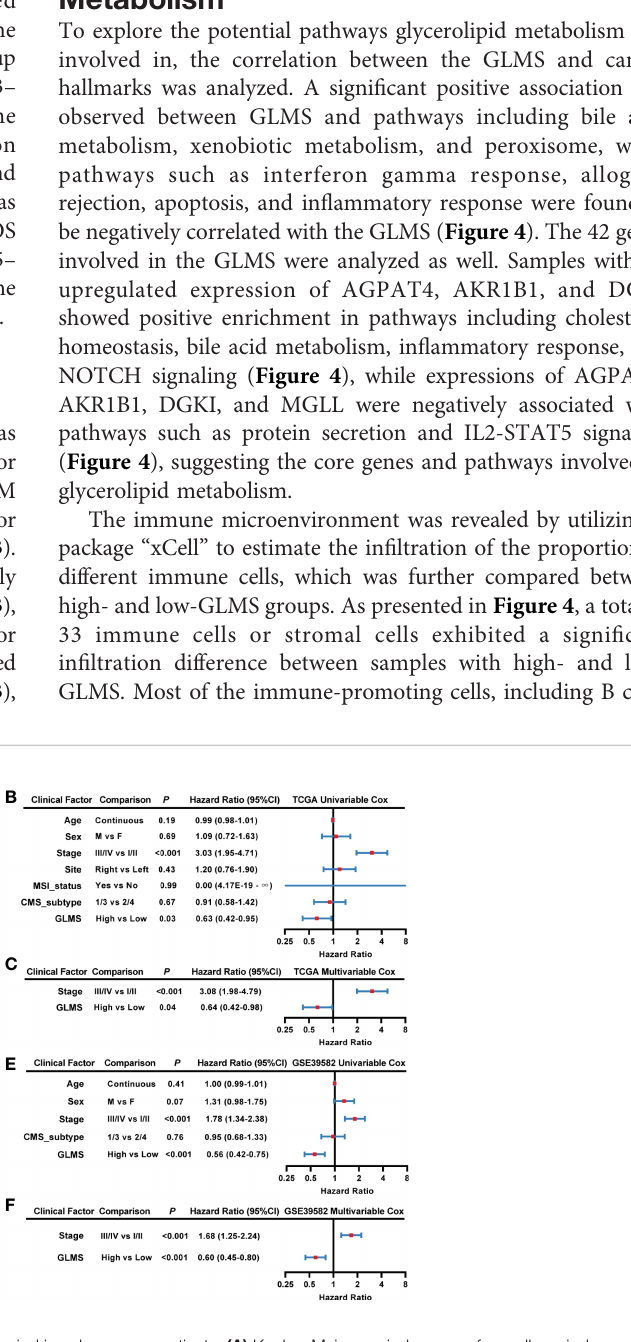
FIGURE 2 | Association between glycerolipid metabolism score (GLMS) and survival in colon cancer patients. (A) Kaplan – Meier survival curves of overall survival comparing the high- and low-GLMS groups in TCGA-COAD dataset, which showed improved median overall survival (OS) in the high-GLMS group compared with the low-GLMS group (not reached vs. 2,134 days). (B, C) The forest plot of the univariable (B) and multivariable (C) Cox regression analysis in TCGA-COAD cohort. (D) Kaplan – Meier survival curves of overall survival comparing the high- and low-GLMS groups in the GSE39582 dataset, which showed improved median overall survival (OS) in the high-GLMS group compared with the low-GLMS group (not reached vs. 2,850 days). (E, F) The forest plot of the univariable (E) and multivariable (F) Cox regression analysis in the GSE39582 cohort. HR, hazard ratio; 95% CI, 95% con fi dence interval; CMS, consensus molecular subtype; MSI, microsatellite